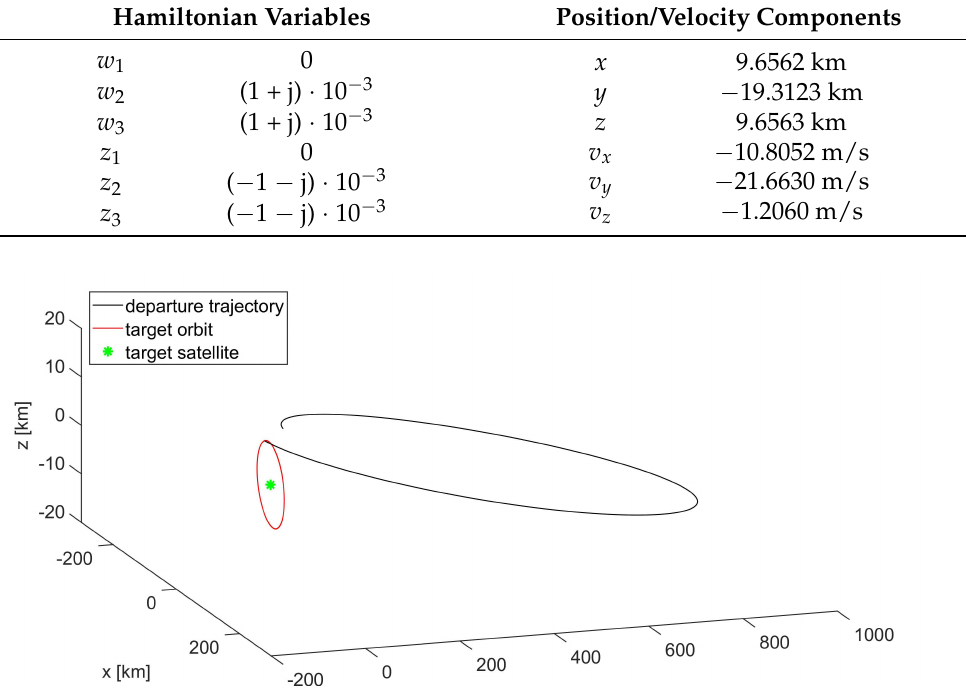
Table 16. Lunar formation: state of reconnaissance satellite after the maneuver.